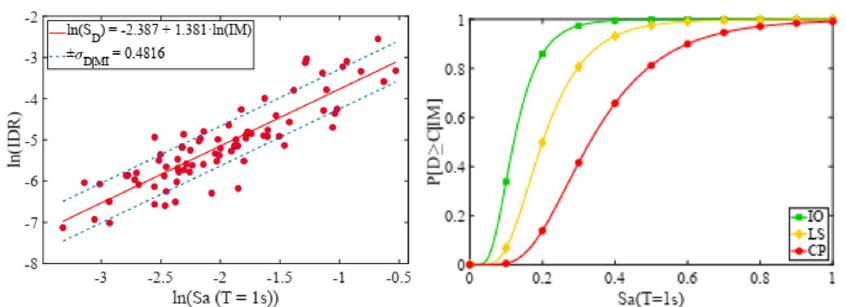
Figure 6. Probabilistic Seismic Demand Model (PSDM) (left) and fragility functions (right) of the analyzed RC